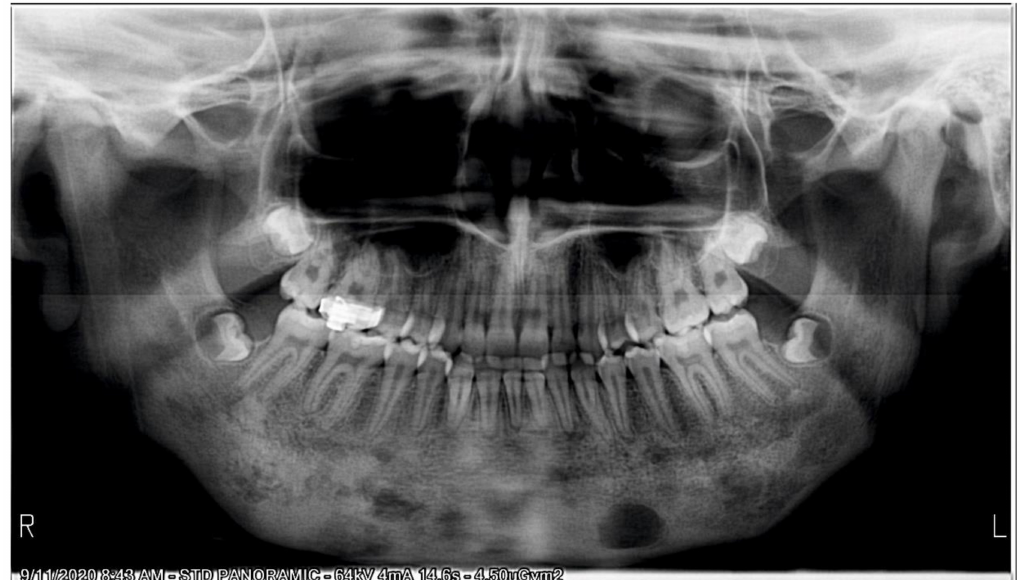
Figure 26. Panoramic radiograph at the one-year follow-up appointment. Cephalometric analysis at the end of treatment shows that the gonial-jaw angle has remained constant, while the articular angle is now in the normal range. Corpus length is still short, but has slightly increased since the beginning of treatment, meaning that there is a normal anterior growth pattern. From the dental point of view, lower incisors position is now normal, and there is protrusion of the upper incisors, due to the autorotation of the mandible and protrusion of the lower incisors (Figure